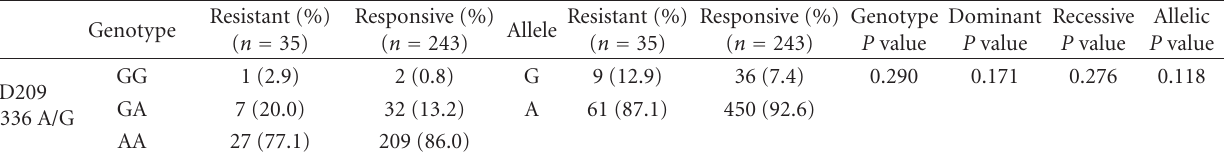
Table 2: Genotyping and allele frequency of CD209 − 336 A/G in patients resistant and responsive to intravenous immunoglobulin (IVIG) treatment.